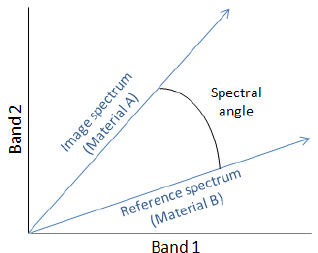
Figure 3. Spectral angle between image and reference spectra in SAM algorithm (Rashmi et al.,